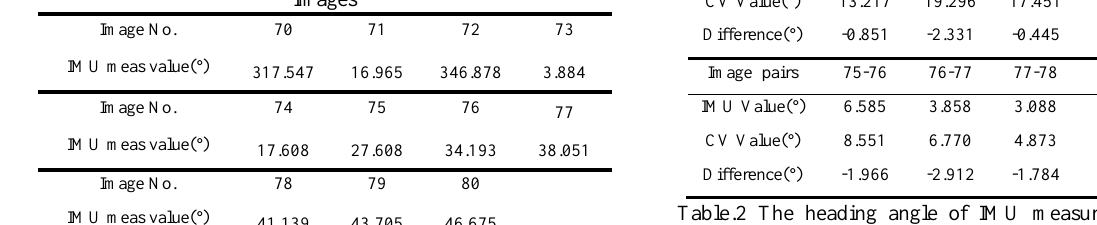
Table.1 The Heading IMU measurement value of sequential